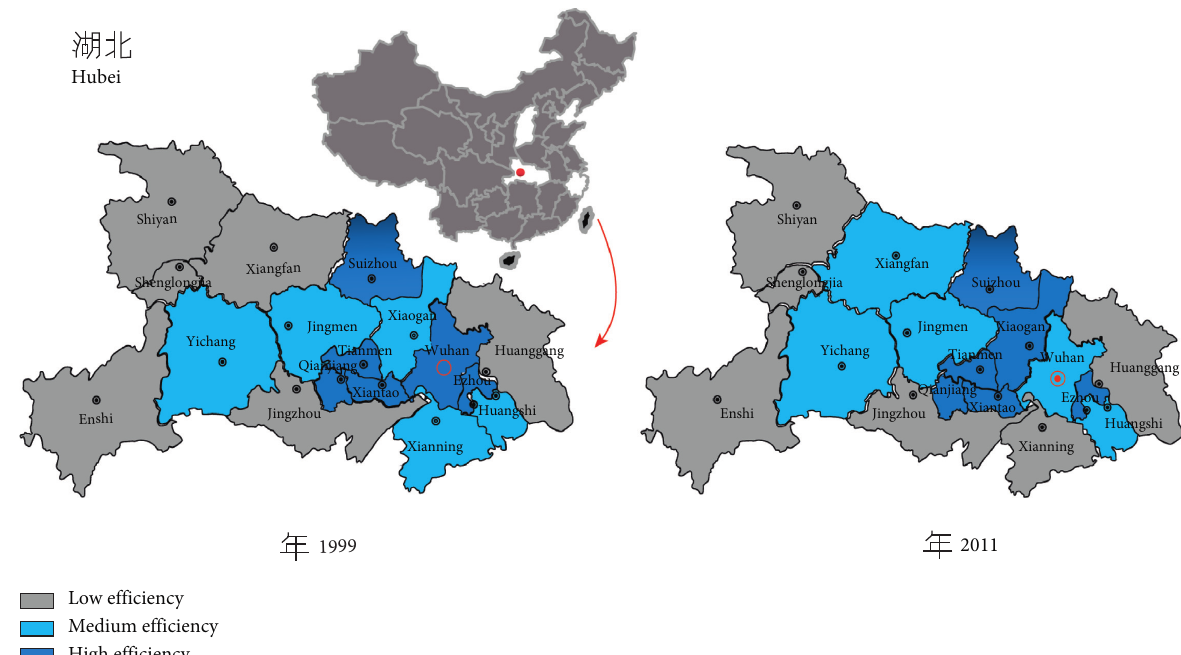
Figure 1: Grouping of the 17 prefectures by production efficiency of manufacturing